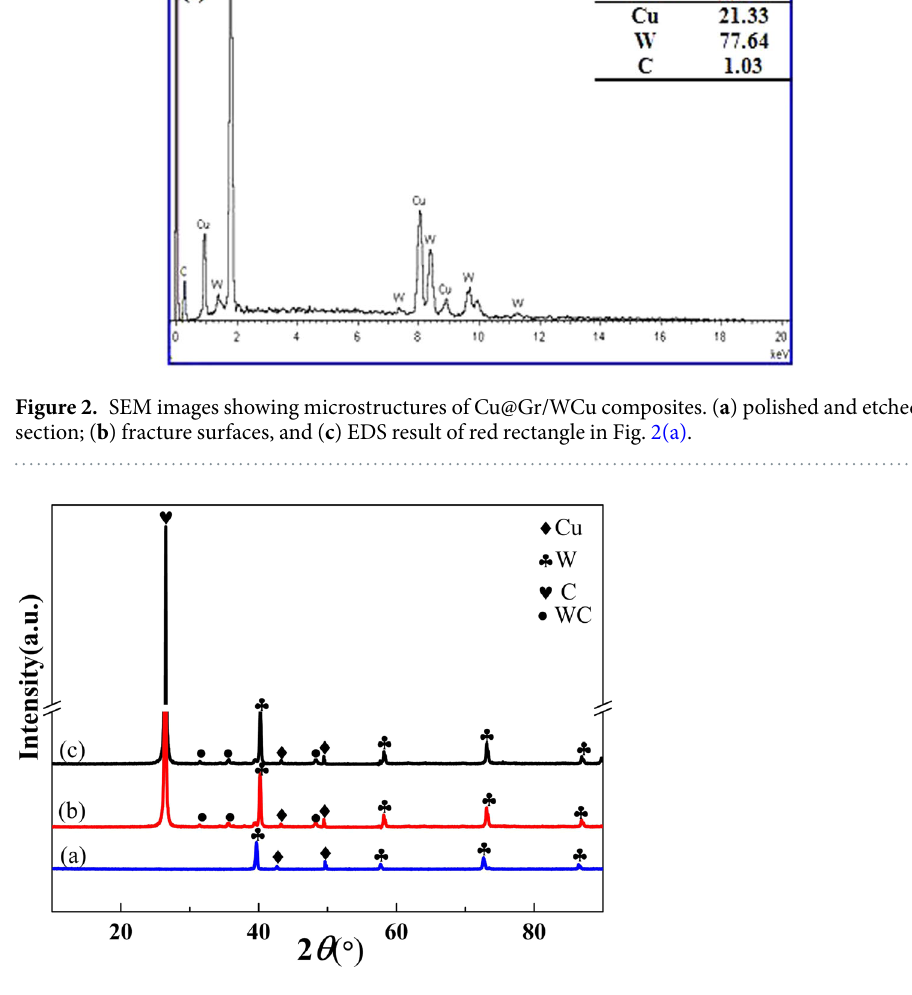
Figure 3. XRD patterns of ( a ) WCu composites, ( b ) doped with 0.8 wt.% graphene, and ( c ) doped with 0.8wt.%